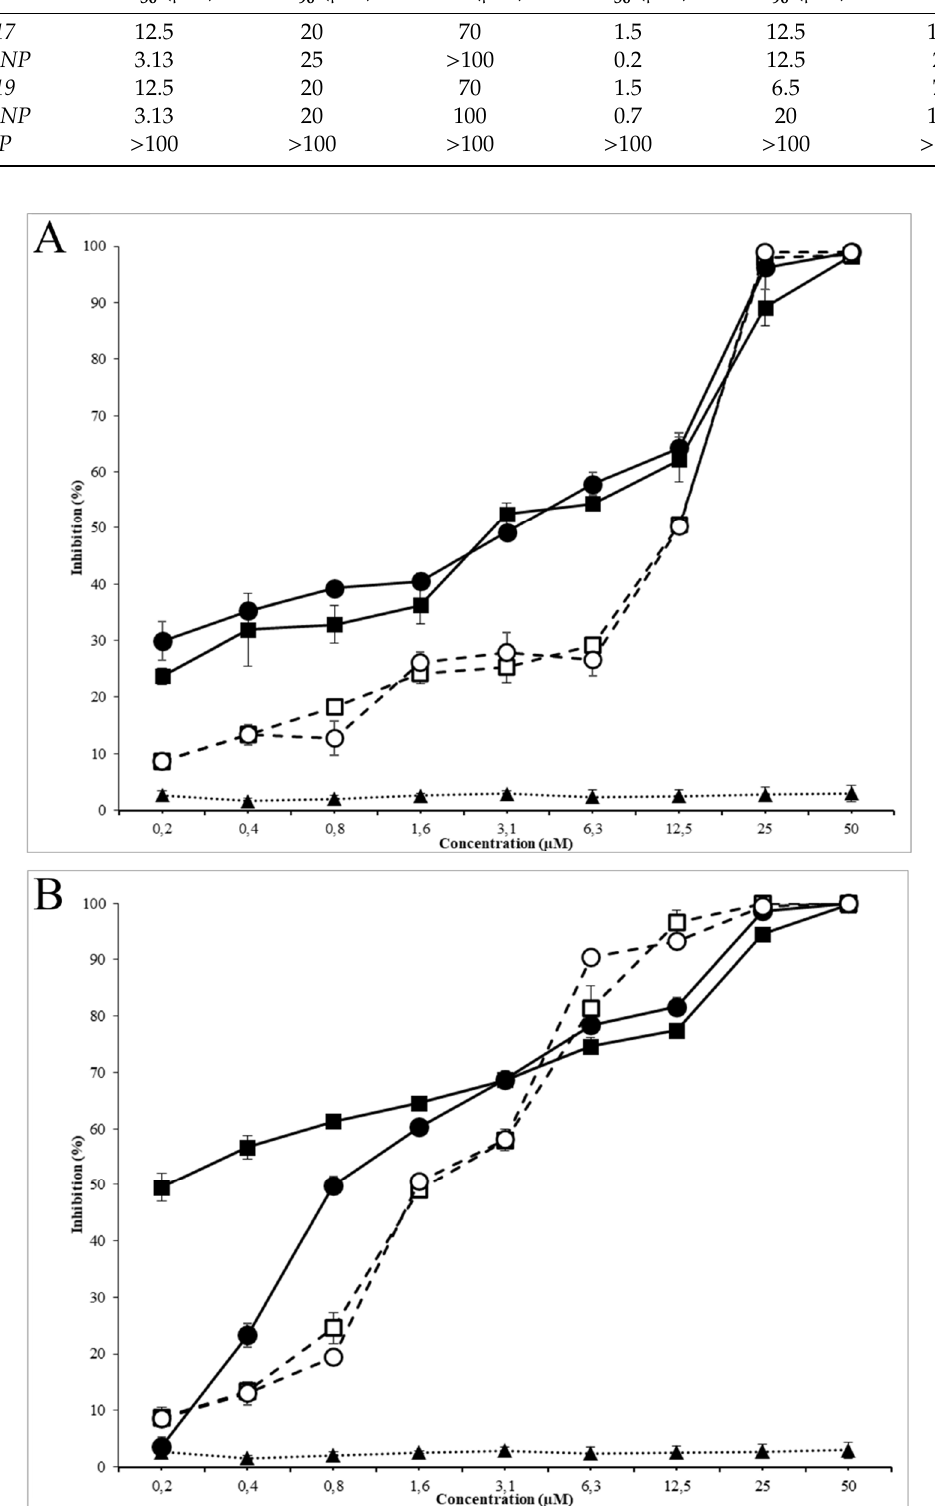
Figure 5. Antimicrobial activity of G19NP, G19 and NP against E. coli ( A ) and MRSA ( B ). ( ■ ) G17NP, ( □ ) G17, ( ▲ ) Empty nanoparticle, ( ● ) G19NP, ( ○ ) G19. Data are the mean ± SD (n = 3). Table 3. Antimicrobial activity of free and encapsulated G17 and G19.